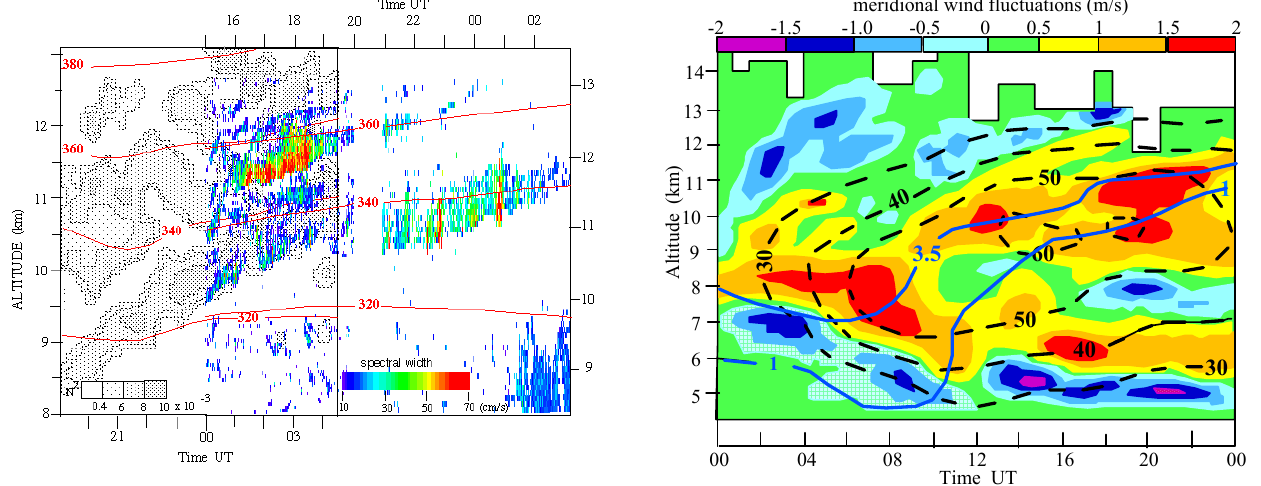
Fig. 10. Meridional wind fluctuations observed by the Lannemezan VHF radar. In the same cross section, the wind field (broken lines, in m/s), observed by the Lannemezan radar, and iso lines PV = 1 and PV = 3 . 5 · 10 − 6 m 2 s − 1 K kg − 1 , (blue lines) derived from the ECMWF analysis, are also